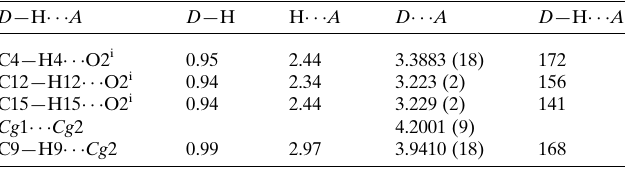
Table 2 Hydrogen-bonding geometry and (cid:4) – (cid:4) interactions (A˚ , (cid:3) ). Cg 1 and Cg 2 are the centroids of the N1/N2/C3/C2/C1 and N3/N4/C7/C6/C5 rings, respectively. D —H (cid:4)(cid:4)(cid:4) A